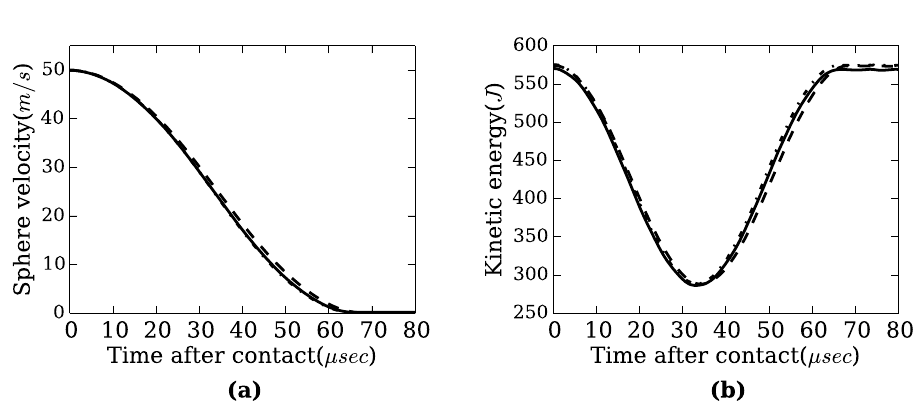
Figure 4. ( a ) Velocity profiles of the moving sphere versus time after contact. The sphere slows down and eventually reaches stationary through the contact, indicating that the collision is elastic. ( b ) Kinetic energy of the system versus time after contact. The kinetic energy is reduced through the contact and increased back to the initial value. Along with the velocity profile, it shows the kinetic energy of the moving sphere is transferred to the stationary sphere, which is another indication of the elastic collision. (Solid line) (cid:31) (cid:31) 2 23 , (half dashed line) (cid:31) 2 24 . The profiles of all the three cases are nearly indistinguishable. This would = = suggest the similarity of the phenomena by the